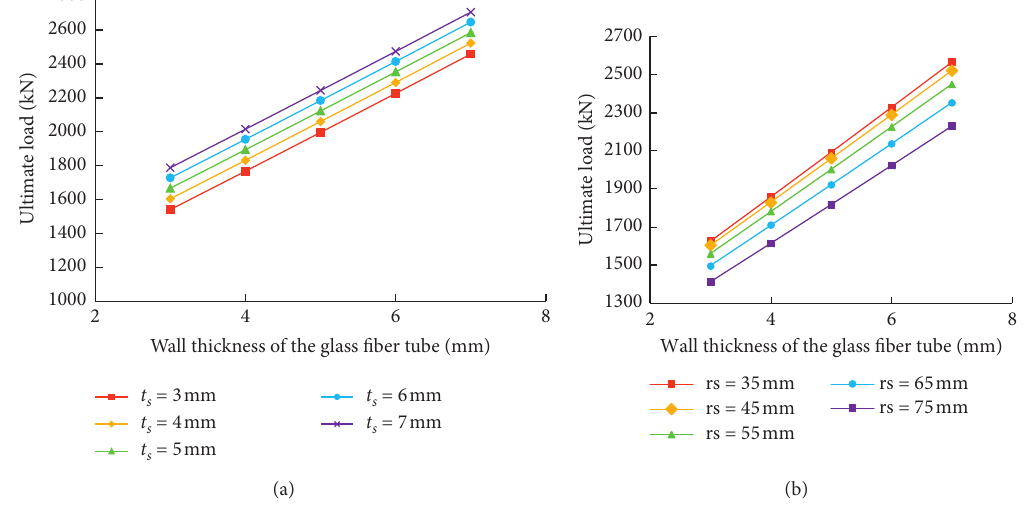
Figure 10: Influence of thickness of the glass fiber tube on ultimate